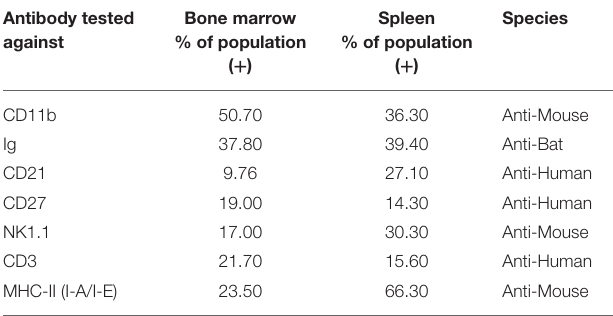
TABLE 2 | Detection of immune cell subsets in bat bone marrow and spleen using cross-reactive antibodies. Antibody tested Bone marrow against % of